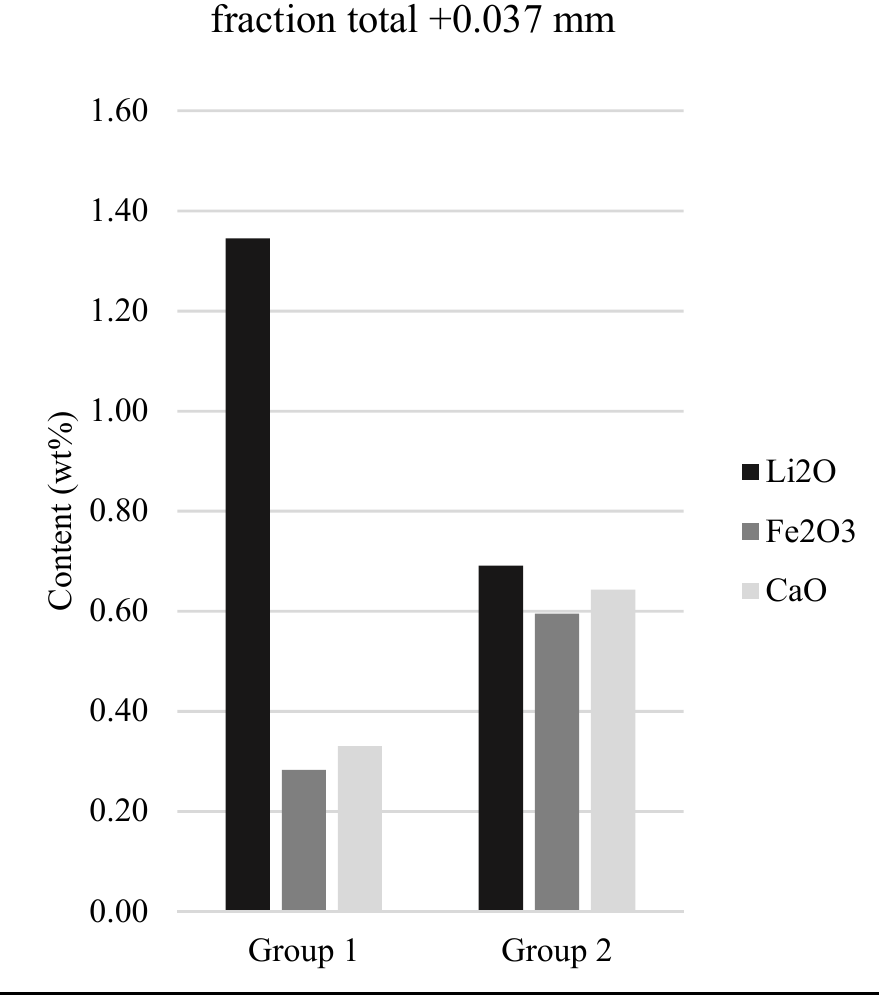
Figure 5. Li 2 O, Fe 2 O 3 , and CaO contents in the size fraction of total +0.037 mm.